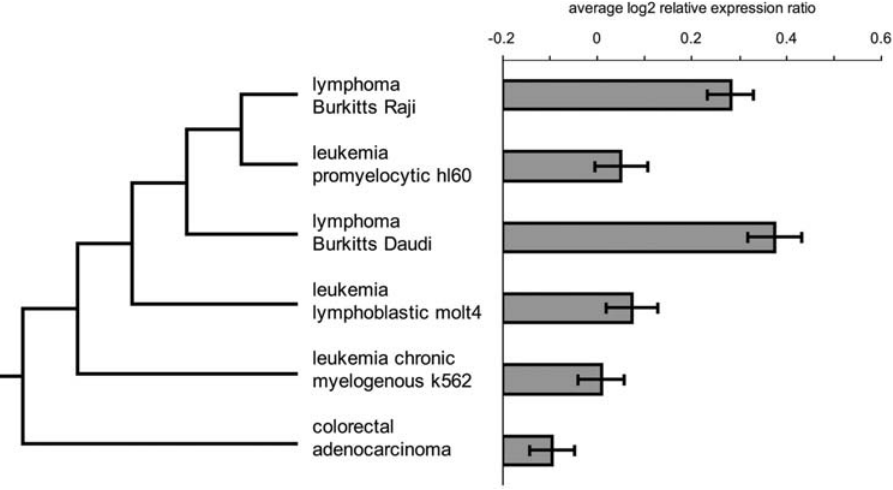
Figure 8. Relationships and average relative expression levels among the cancer tissues samples from the Novartis Symatlas microarray dataset. A dendogram relating the cancer samples based on similarities (differences) among relative expression levels is shown along with the average relative expression levels for all genes with hsa-mir-548 target sites in each of the cancer samples.